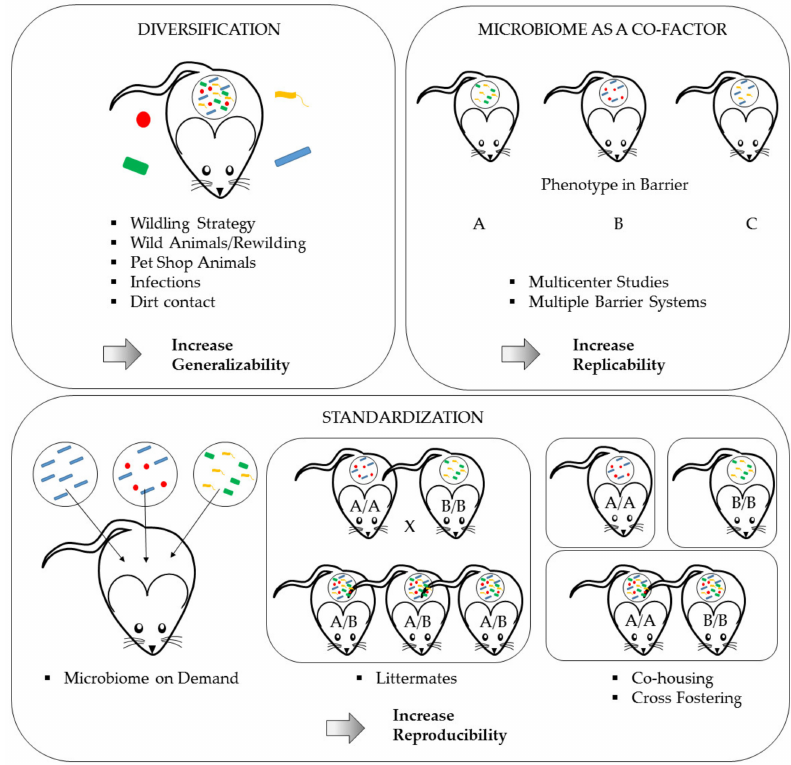
Figure 4. Measures to ensure research validity in the microbiome era. Intentional microbiome diversification will increase the overall generalizability of study results. Using the microbiome as a co-factor by comparing phenotypes from studies under different barrier conditions will uncover microbiome impacts on phenotypes. Thus, this method will identify stable phenotypes and therefore increase the replicability of findings. Finally, achieving a high level of microbiome standardization will markedly improve study